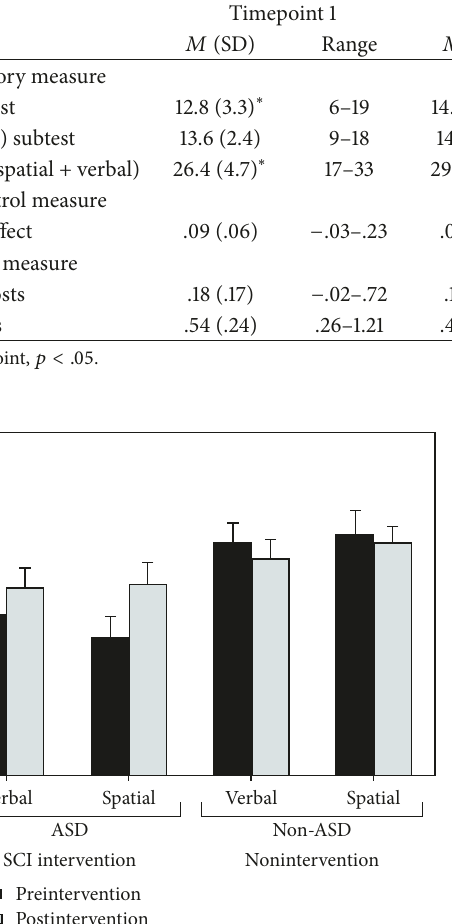
Figure 3: Mean inhibitory control effect [ ( RT INCOMPATIBLE − RT COMPATIBLE )/ RT COMPATIBLE ] for the inhibitory control test, shown separately for each group (ASD and non-ASD) and timepoint (before and after intervention). Error bars represent standard error of the